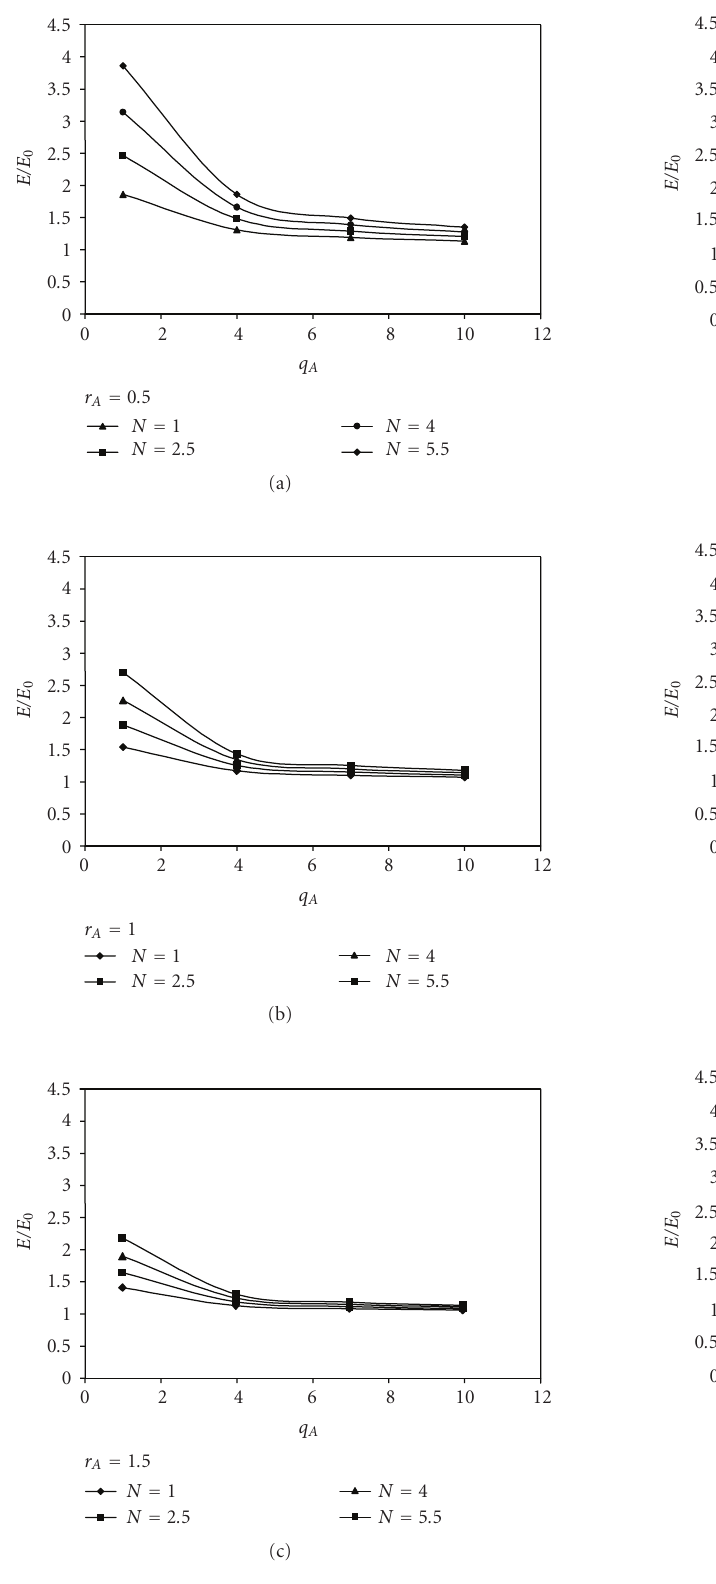
Figure 2: Enhancement factors as a function of q A for the SO 2 – slurry system. Enhancement factors as a function of q A Mg(OH) 2 for the SO 2 –Mg(OH) slurry system. Enhancement factors as a 2 slurry system. function of q A for the SO 2 –Mg(OH) 2